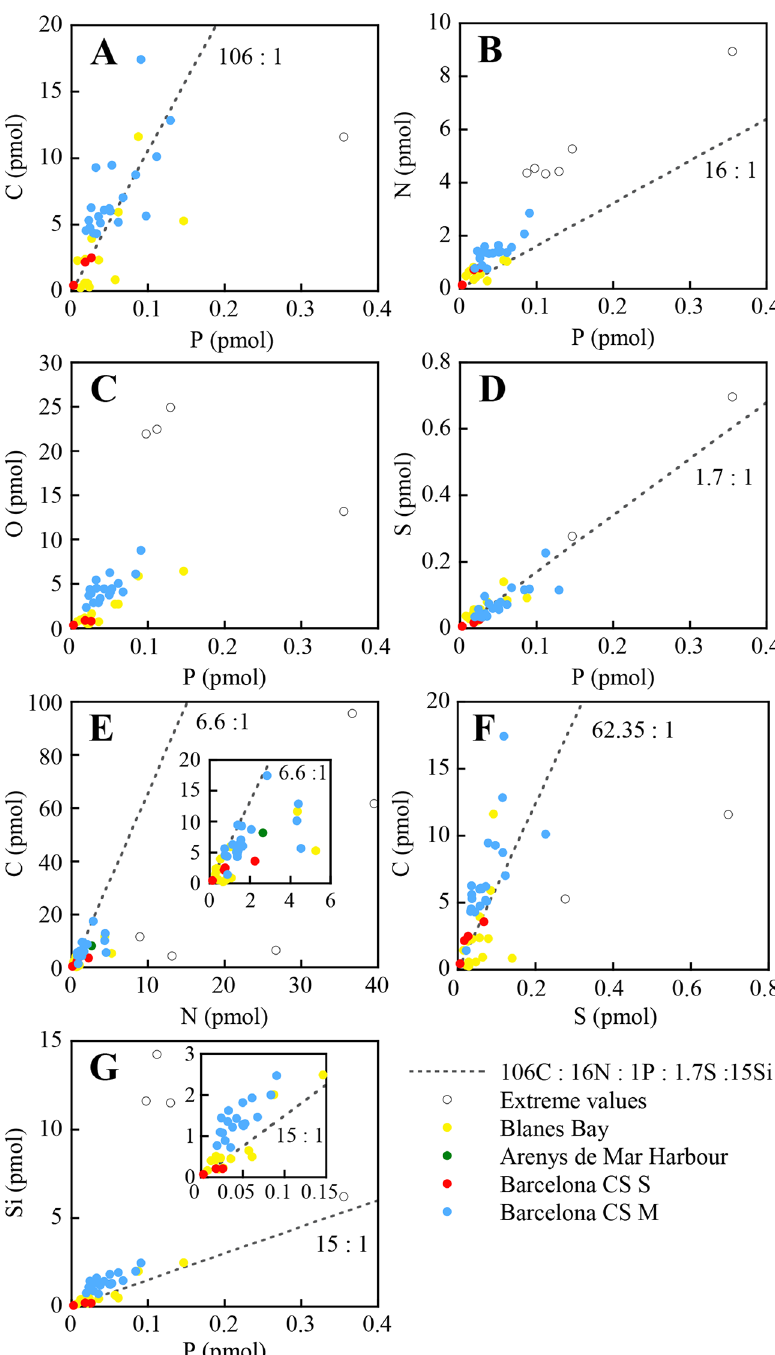
Fig 5. Molar relationships between C, N, O and S vs . P, C vs . N and S, and Si vs . P of individual diatoms from the NW Catalan Sea. Cells from the same location are plotted with the same colour. Note that axes